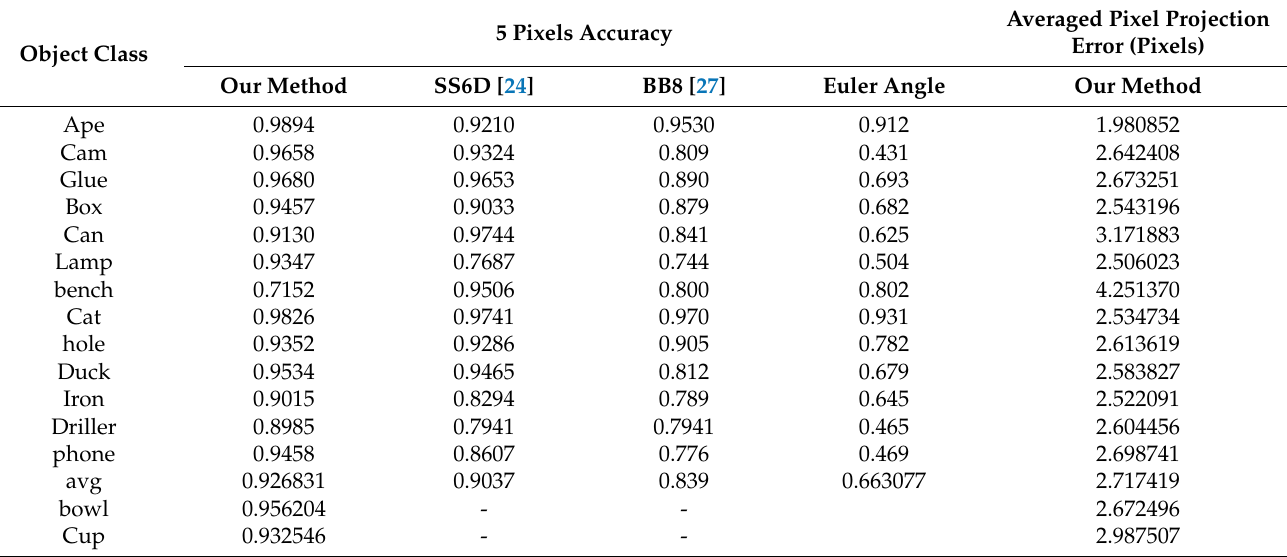
Table 1. LineMod 2 objects of 2D Projection pixel and projection error comparison.